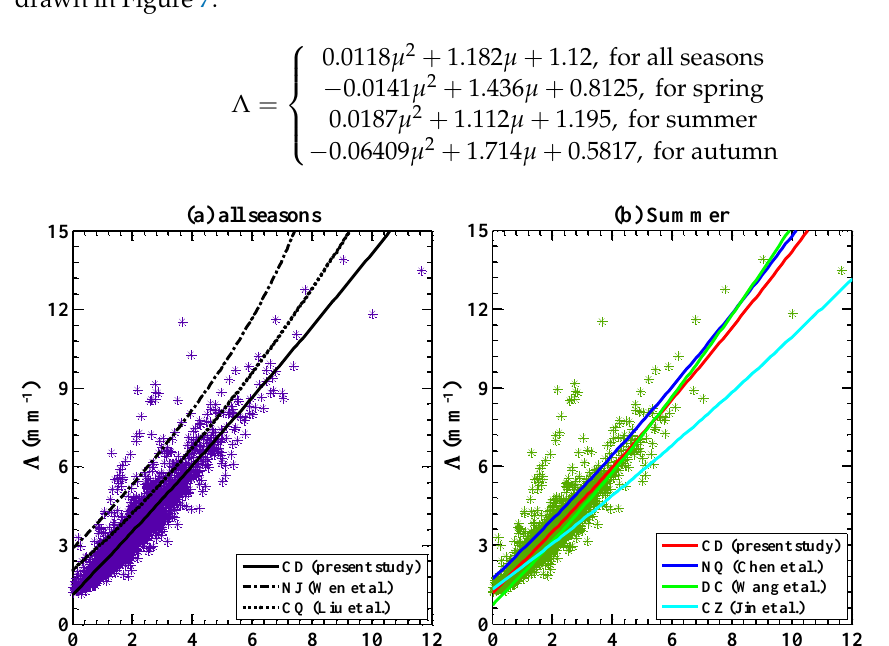
Figure 7. Scatterplots and fitting results of the Gamma parameters of Λ and µ and comparisons among different observational regions. ( a , b ) for samples in all seasons (the purple asterisks) and summer (the green asterisks), respectively. NJ, CQ, NQ, DC, and CZ denote Nanjing (located in east China, Wen et al., 2017 [20]), Chongqing (located in eastern Sichuan Basin, Liu et al., 2021 [46]), Naqu (located in the mid-Tibetan Plateau, Chen et al., 2017 [22]), Daocheng (located in the eastern Tibetan Plateau, Wang et al., 2020 [13]), and Chuzhou (located in the east China, Jin et al., 2015 [35]).